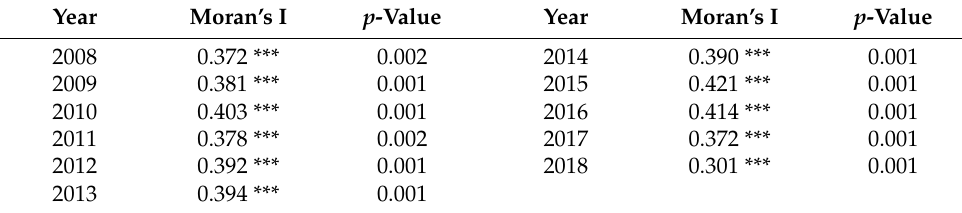
Table 3. Moran’s I index of the coordination level of production-living-ecological function coupling.